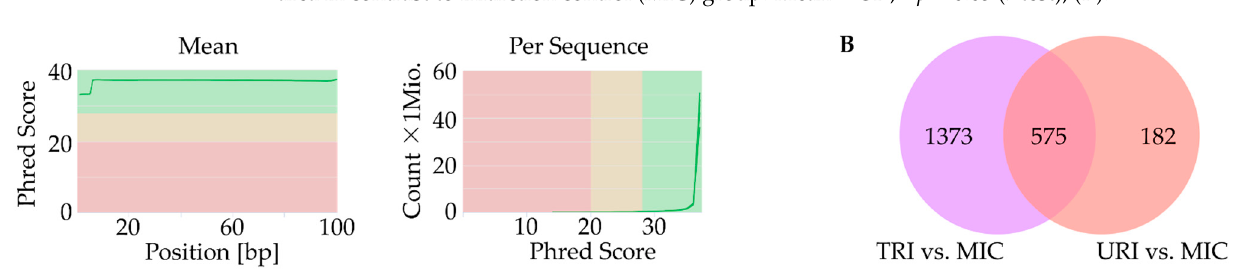
Figure 3. Change of myocardial infarct scar: Fast green/Sirius red staining of the murine heart cross sections 10 days after 1st LAD ligation showed a significant decrease of the infarction size in case of stem cell treatment (TRI) in contrast to untreated infarction (URI + MIC). Mean ± SD; * p = 0.05 ( t -test); ( A ). Analysis of the leukocytes infiltration using Hematoxylin/Eosin staining 48 h after a 2nd LAD ligation in animals of URI and TRI group showed significant enlargement of the infarct scar area in contrast to infarction control (MIC) group. Mean ± SD; # p < 0.05 ( t -test); ( B ).